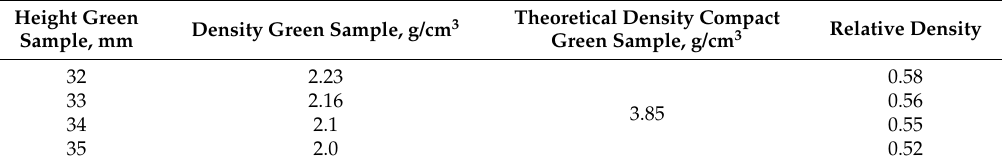
Table 1. Characteristics of the initial